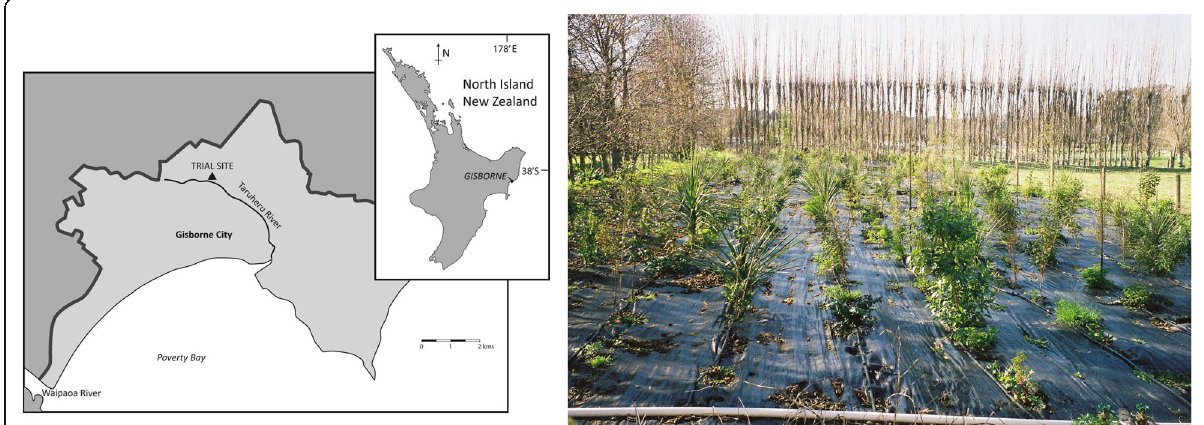
Fig. 1 Location map with photograph of 3-year-old plants at the trial